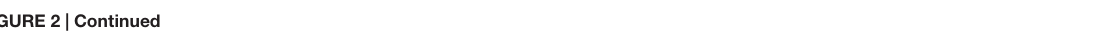
(A) Results of the response-aligned waveform analysis. Values are masked by results of cluster-based non-parametric analysis: only significant values are plotted. Within the left panel, upper part corresponds to left hemisphere electrodes, middle part to midline electrodes, and lower part to right hemisphere electrodes; within each part, electrodes are ordered from posterior to anterior. Dashed lines outline representative electrodes, which time course is plotted separately (picture naming in black, word reading in gray). The topography represents the spatial distribution of the effect over each cluster (white dots outline electrodes within each cluster). (B) Results of the spatio-temporal segmentation on the response-locked ERP Grand-Means of both tasks. Each period of topographic stability is displayed in the color bars with the information about its time course. The corresponding topographies are listed on the right (positive values in red, negative values in blue), with the common topographies marked in red. The gray bar on the temporal axis represents the periods of topographic difference between tasks, as revealed by the TANOVA. (C) Boxplots of distributions of individual offsets of maps F and durations of map G, extracted from the back-fitting procedure for both picture naming (bold lines) and word reading (thin lines). Zero of times in the boxplot of the offset of map F represents voice